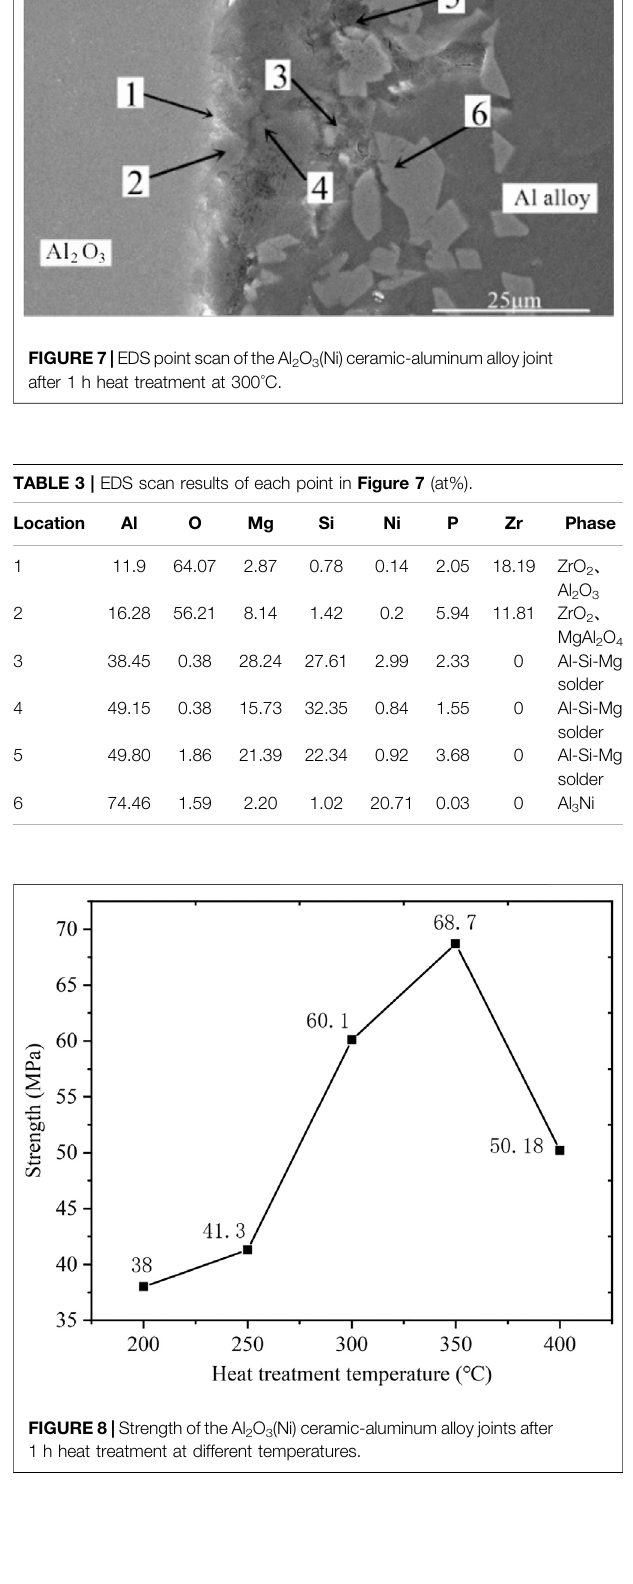
Frontiers in Materials |